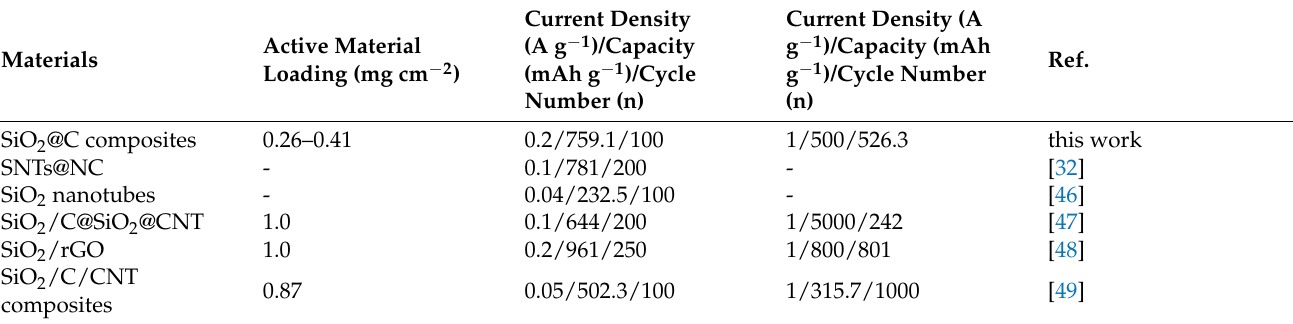
Table 1. Previous works on silica-based anodes in recent years.